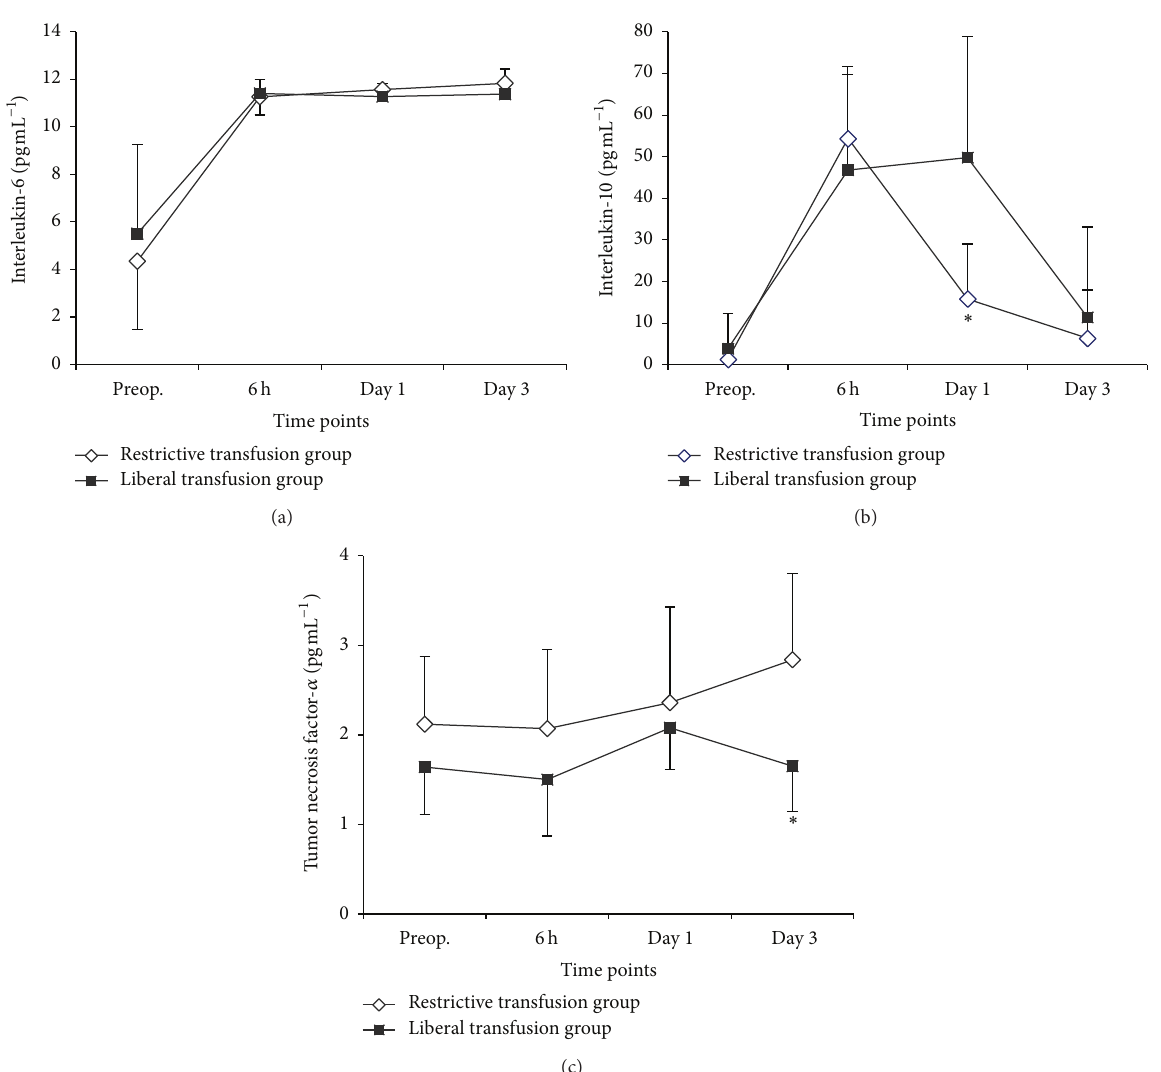
Figure 1: (a) Serial changes in perioperative IL-6 levels. Data are presented as mean ± SD. No intergroup differences were demonstrated. ( 𝑃 < 0.001 , effect of time; 𝑃 = 0.462 , group by time interaction). (b) Serial changes in perioperative IL-10 levels. Data are presented as mean ± SD. Postoperative systemic induction of IL-10 was significantly exaggerated in the liberal transfusion group 24 h postoperatively. ( ∗ 𝑃 < 0.05 for intergroup comparison; 𝑃 < 0.001 , effect of time; 𝑃 < 0.001 , group by time interaction). (c) Serial changes in perioperative TNF 𝛼 levels. Data are presented as mean ± SD. There was a difference between the two groups on the third postoperative day. ( ∗ 𝑃 < 0.05 for intergroup comparison; 𝑃 = 0.842 , effect of time; 𝑃 = 0.029 , group by time